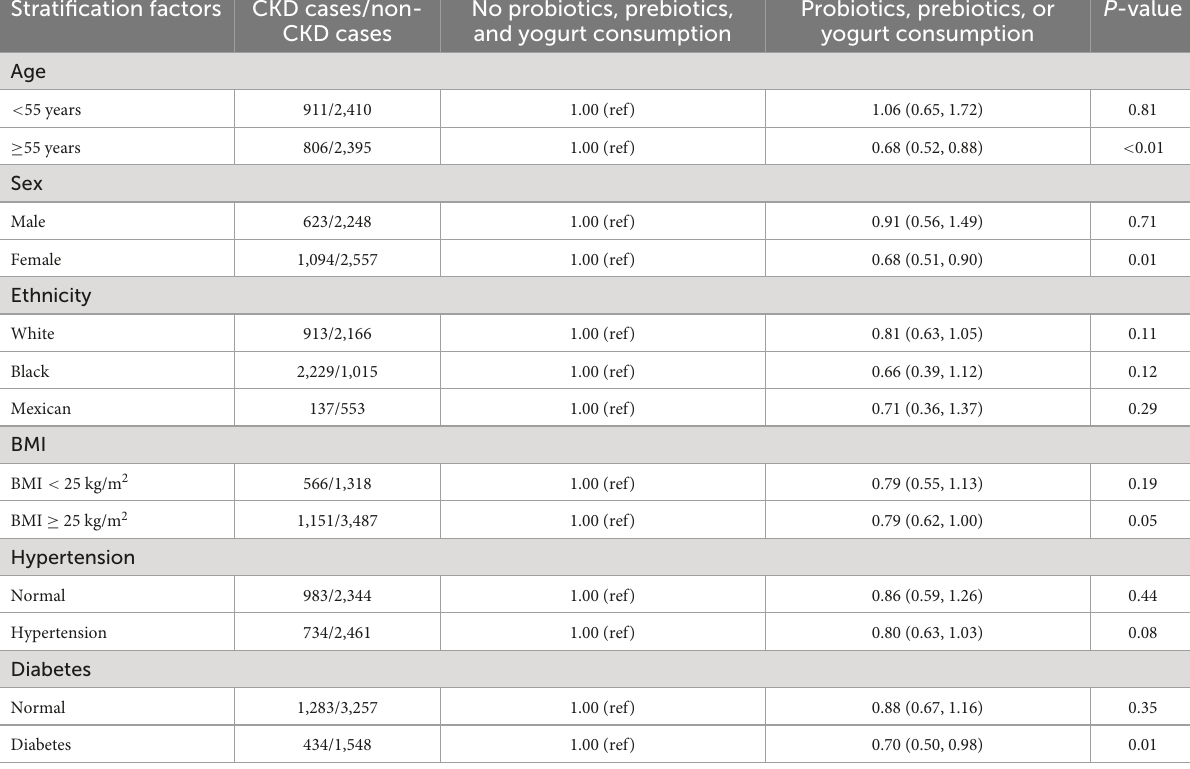
TABLE 3 Multivariable-adjusted odds ratio (95% confidence intervals) of overall chronic kidney disease (CKD) by use of probiotic, prebiotic, or yogurt according to population characteristics.